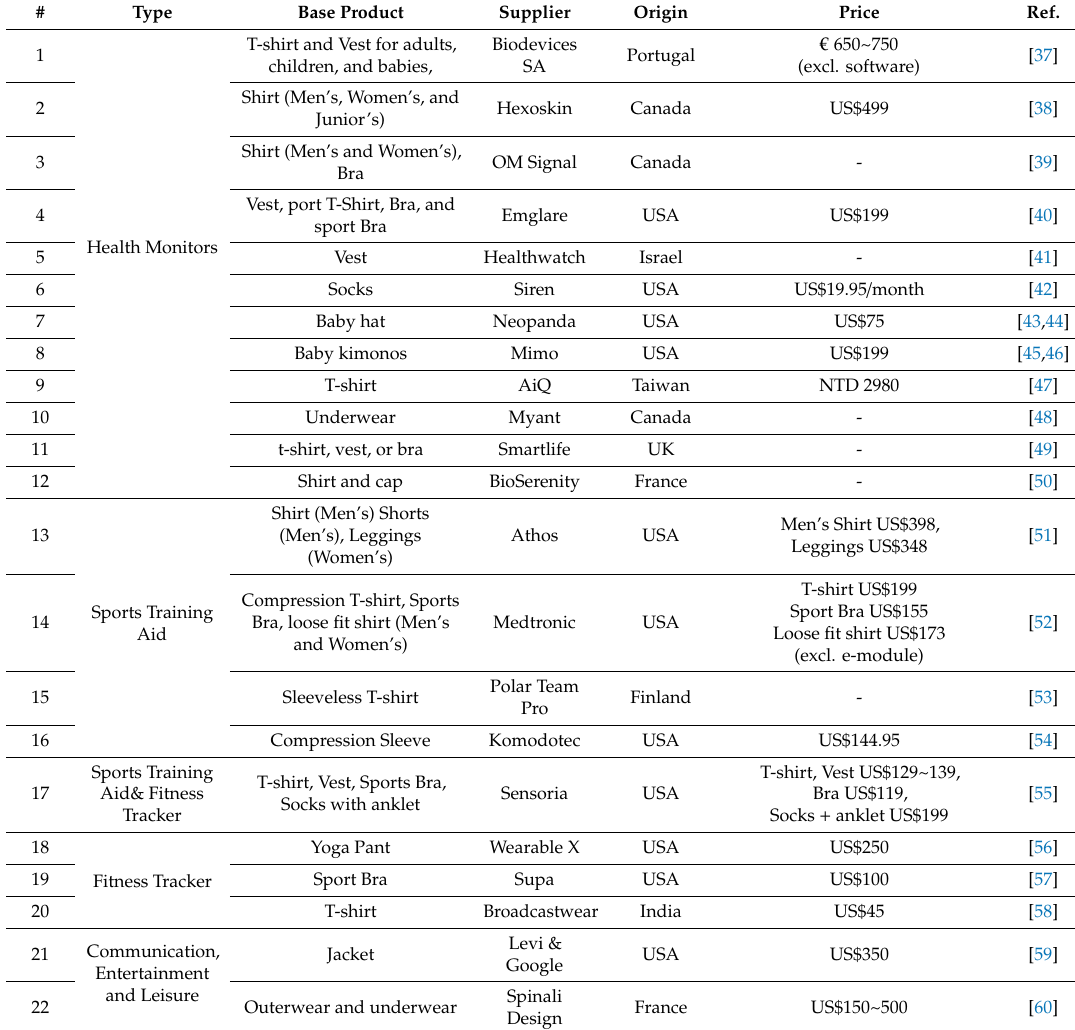
Table 1. List of smart electro-clothing systems (SeCSs) available on the